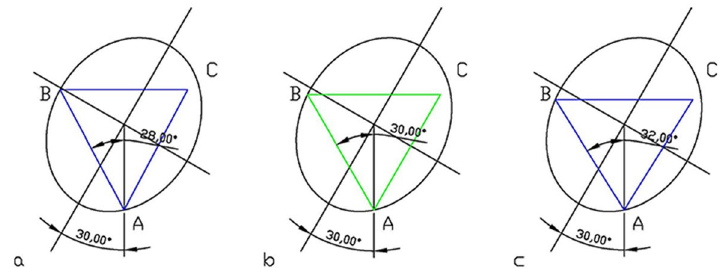
Figure 2. By adjusting the angle between the line connecting point A and point B and the line connecting point A and the center of the ellipse, the area of the largest triangle was gradually approached (ranged from 28° to 32°). The largest area of the isosceles triangles was selected as the inverted isosceles triangle configuration.